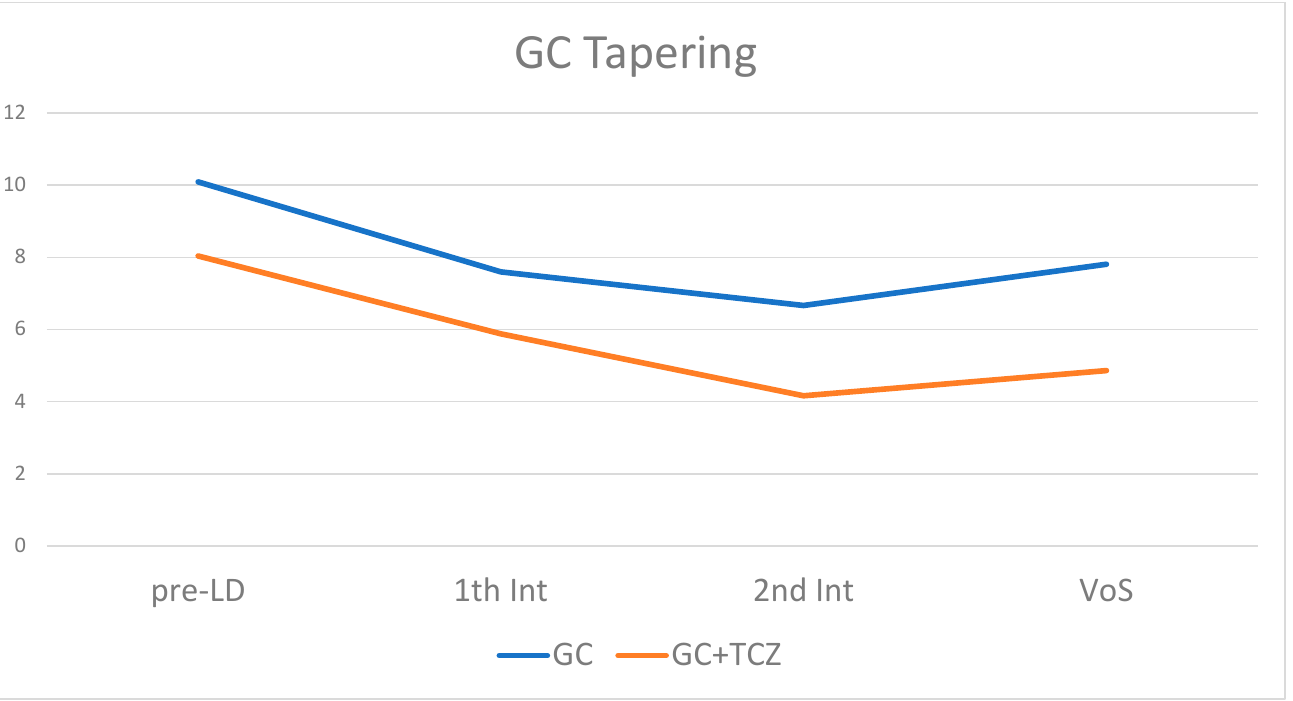
Figure 3. GC scaling in the two different groups of patients treated with and without TCZ. GC: glucocorticoid; TCZ: tocilizumab; pre-LD: pre-lockdown visit; 1th Int: fi rst interview; VOS: visit on site.